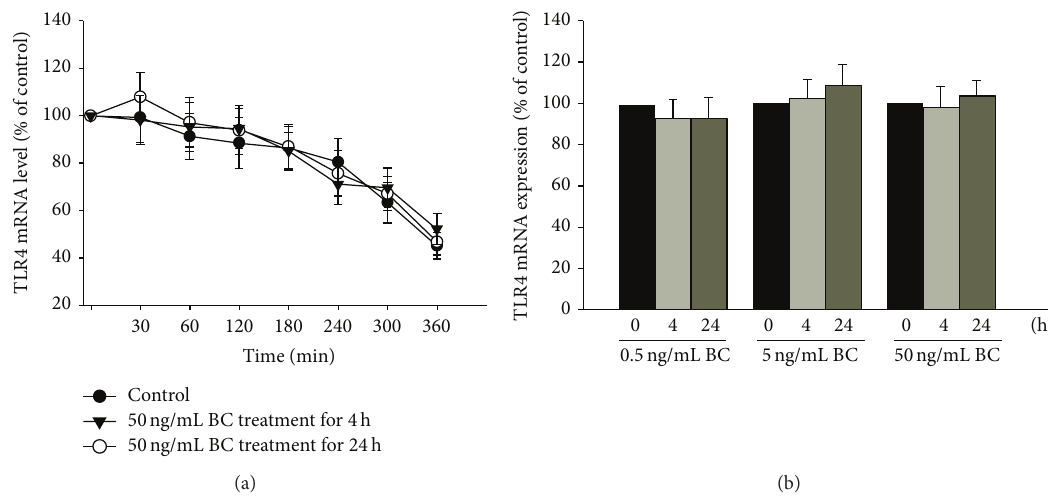
Figure 2: Regulation of TLR4 expression by bone component (BC) exposure in U937 cells not mediated by transcriptional and posttranscriptional modifications. (a) Actinomycin D chase experiment to evaluate thestability of TLR4 mRNAin 50 ng/mL BC-treated U937 cells. (b) U937 cells were treated with 0.5–50 ng/mL BC for the indicated time (4 or 24 h). TLR4 mRNA levels were analyzed by quantitative real-time PCR after normalization to GAPDH mRNA. Data are presented as mean ± SEM ( 𝑛 = 3 ).